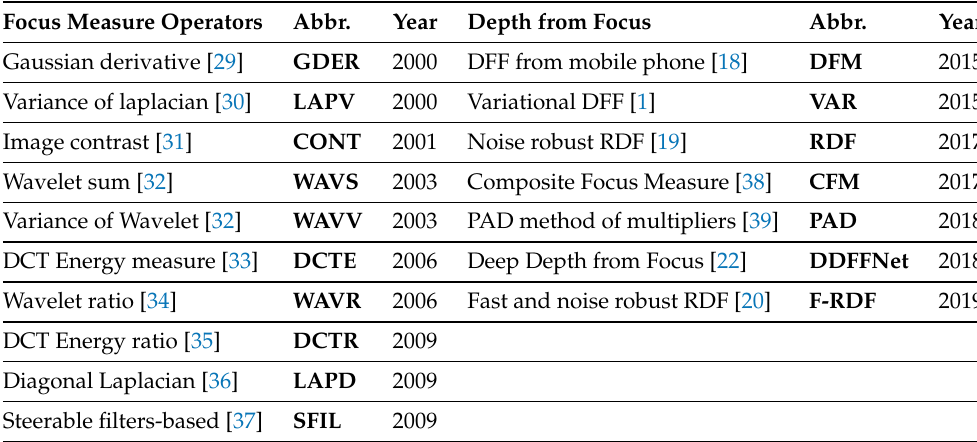
Figure 1. Pipeline of our proposed depth from focus method. Table 1. Focus measure operators and depth from focus (DFF) methods with abbreviation and year of